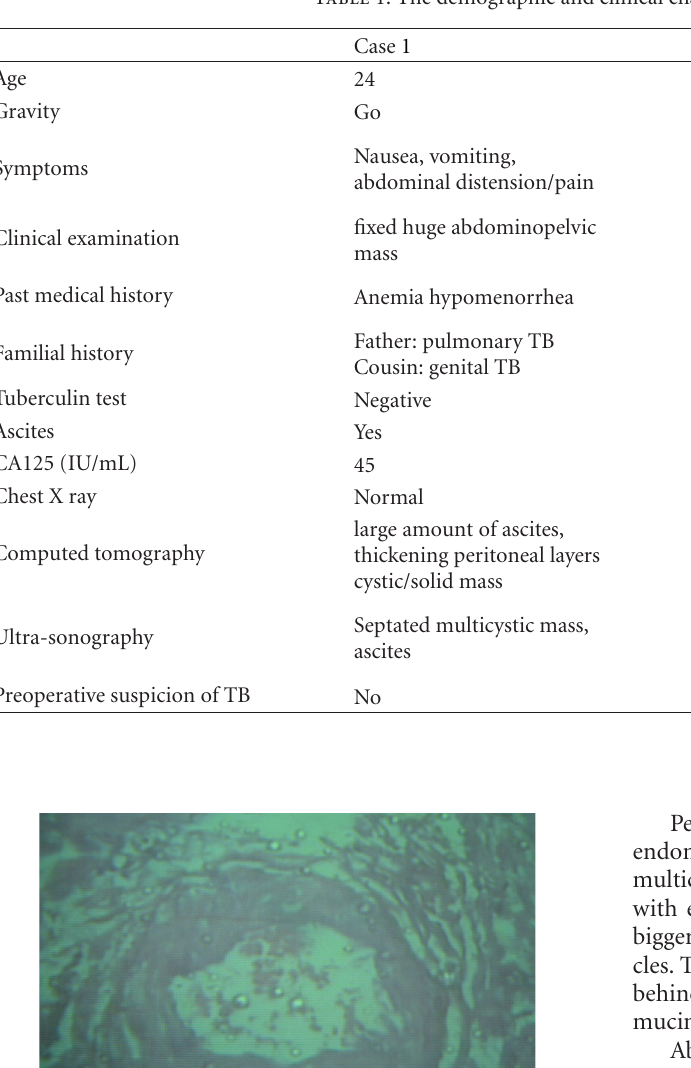
Table 1: The demographic and clinical characteristics of the cases.